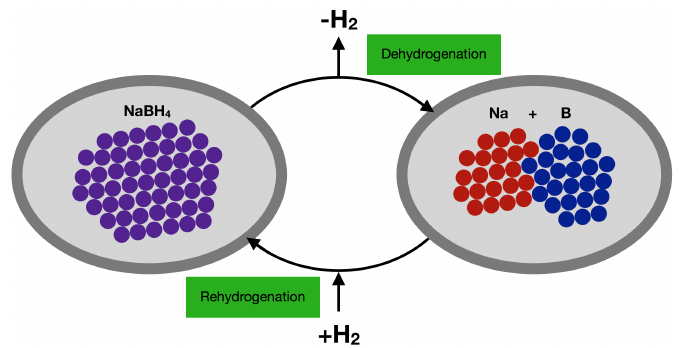
Figure 13. Reversible behaviour of a sodium borohydride (NaBH 4 ) nanoparticle embedded in a nanoscale structure. In this scenario, the confined elements remain in close vicinity during hydrogen cycling, which should facilitate hydrogen